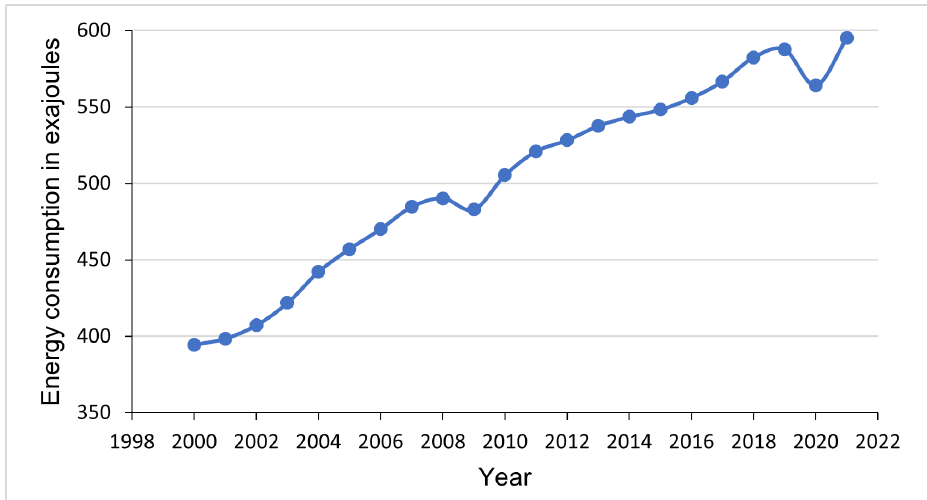
Figure 1. Energy consumption worldwide from 2000 to 2021 (source: https://www.statista.com/